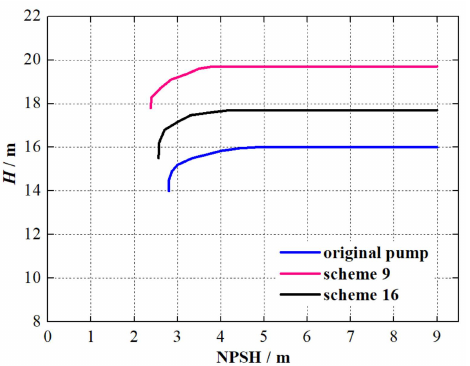
Figure 19. Cavitation performances of scheme 9 pump and scheme 16